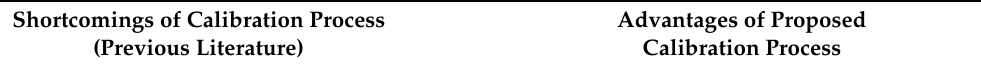
Table 2. Inertial sensor calibration shortcomings mentioned in the previous literature and advantages of the proposed calibration